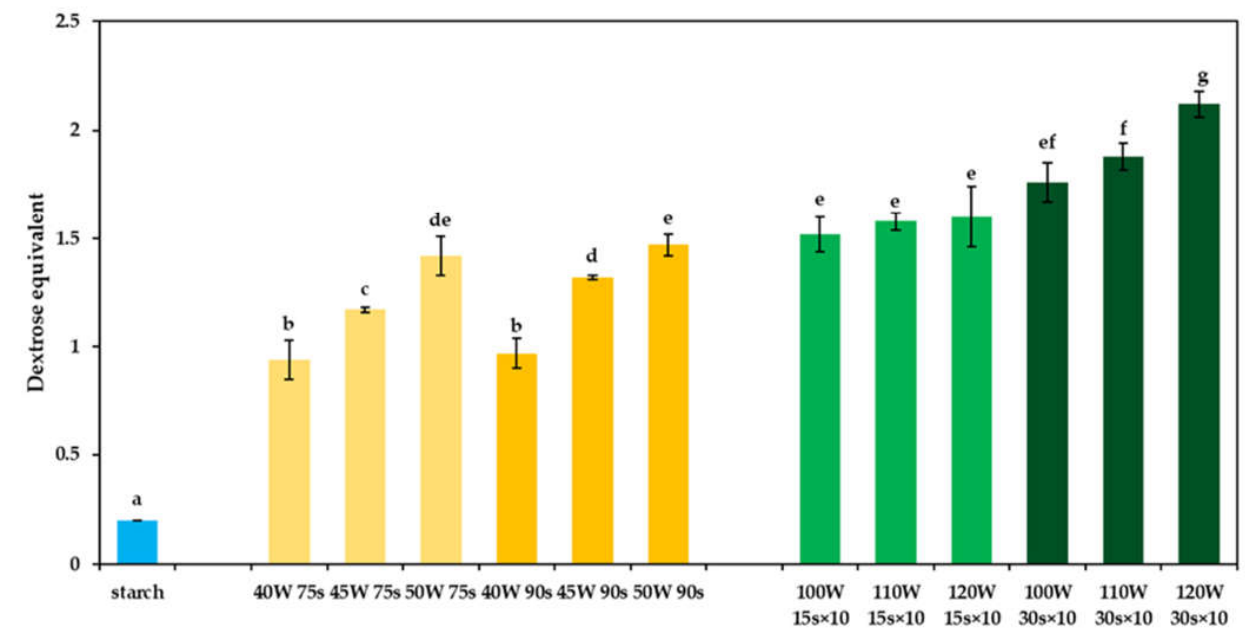
Figure 2. Dextrose equivalent of potato starch (blue) and dextrins prepared by continuous (yellow) and discontinuous (green) microwave-assisted heating. Different superscript lowercase letters (a, b, . . . ) indicate significant differences ( p < 0.05) between each dextrin. Table 1. Color parameters of dextrins obtained after exposure of potato starch to continuous and discontinuous microwave- assisted heating, under acidic conditions.